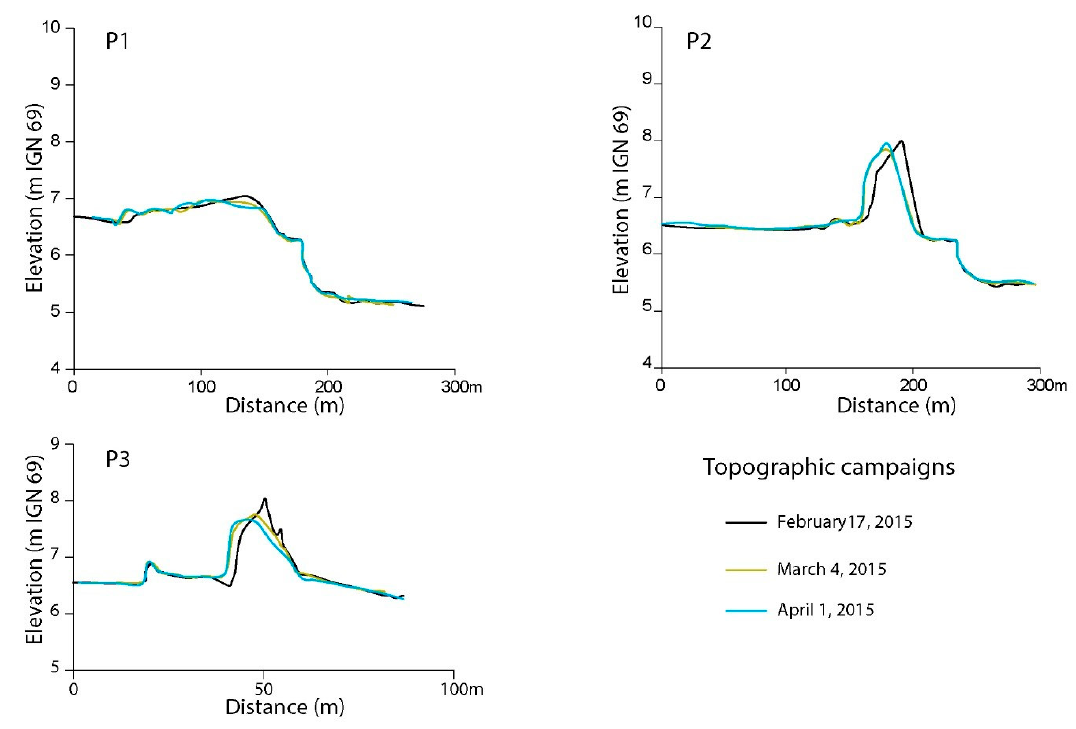
Figure 9. Topographic profile across shelly ridges–P1 and P2: Sainte-Anne site, P3: Les Nielles site.